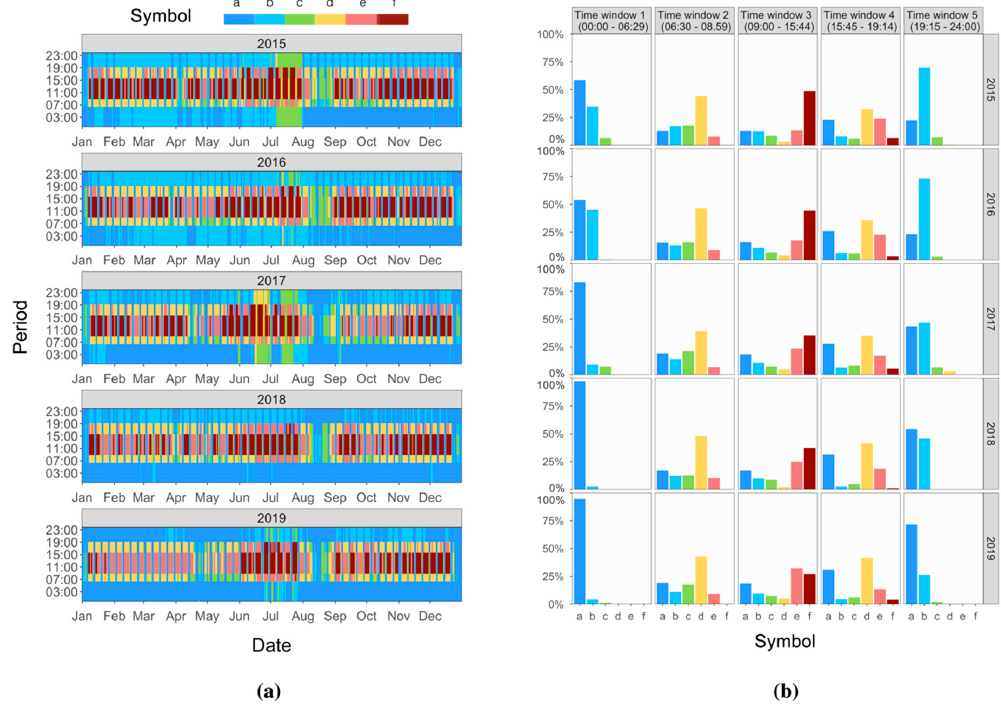
Figure 9. aSAX representation of the total electrical load: ( a ) carpet plots ( b ) histogram distributions of symbols along the time windows and years.